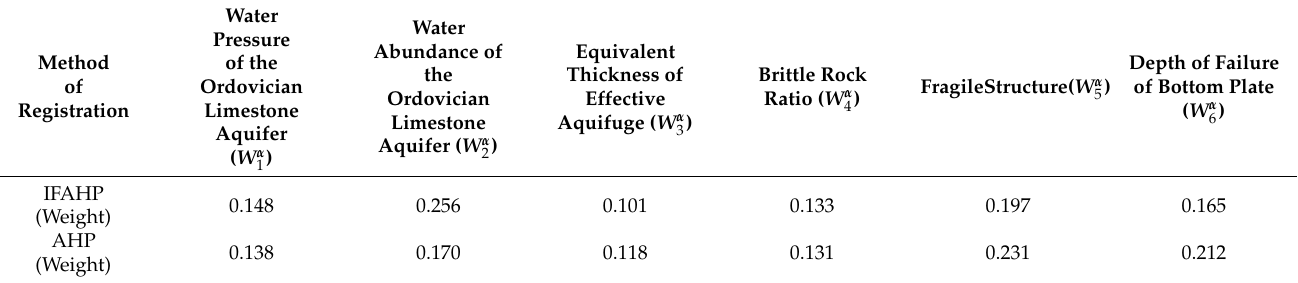
Table 2. Comparison of IFAHP and AHP methods to determine the weight of each main control